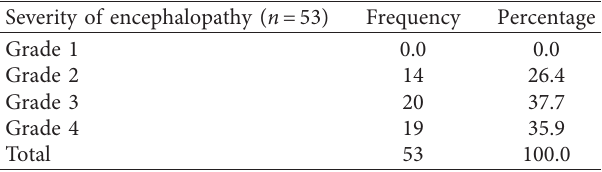
Table 2: Severity of hepatic encephalopathy.